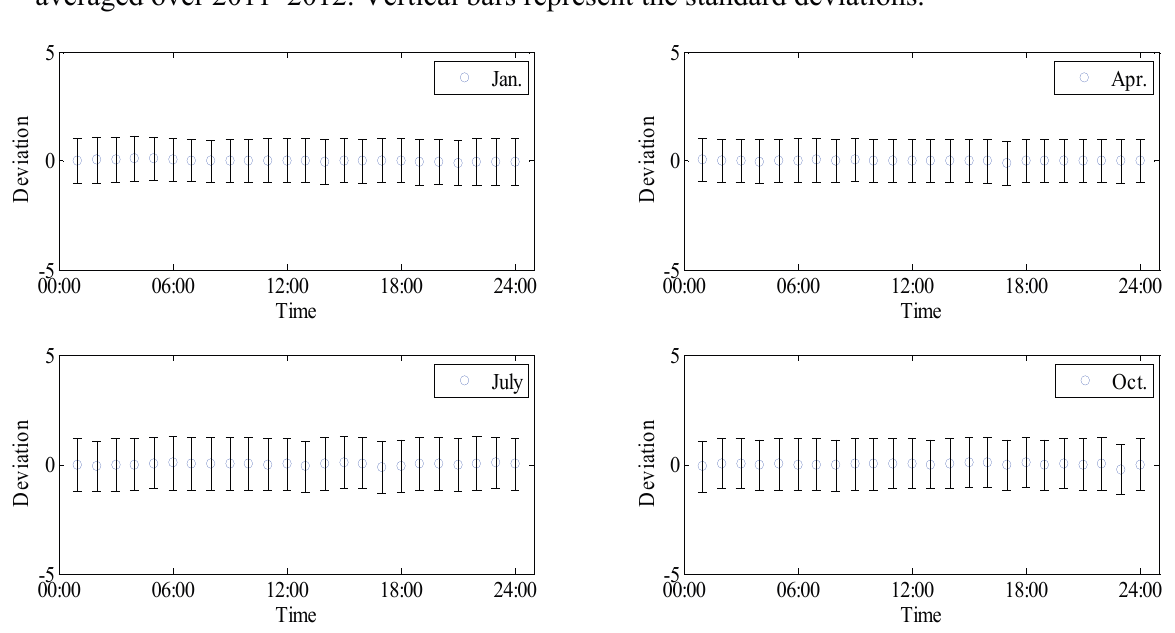
mole fractions from daily 2